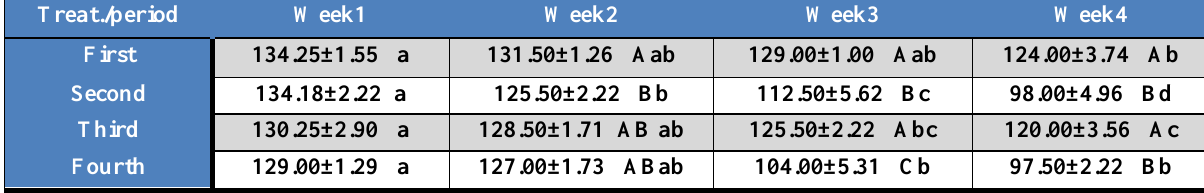
Different capital letters showed significant difference among treatments at the level of (P < 0.05). Different small letters showed significant difference among periods at the level of (P < 0.05).